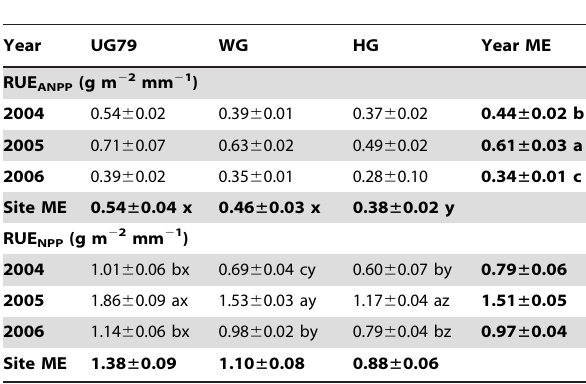
Table 3. F values and the probability ( P . F) of two factored ANOVA results on RUE ANPP , RUE NPP , TE ANPP and TE NPP . Sources Df TE NPP Table 4. Differences between grassland sites and years in rain-use efficiency (RUE, g m 2 2 mm 2 1 ) based on aboveground-(ANPP) and net primary productivity (NPP) in 2004, 2005 and